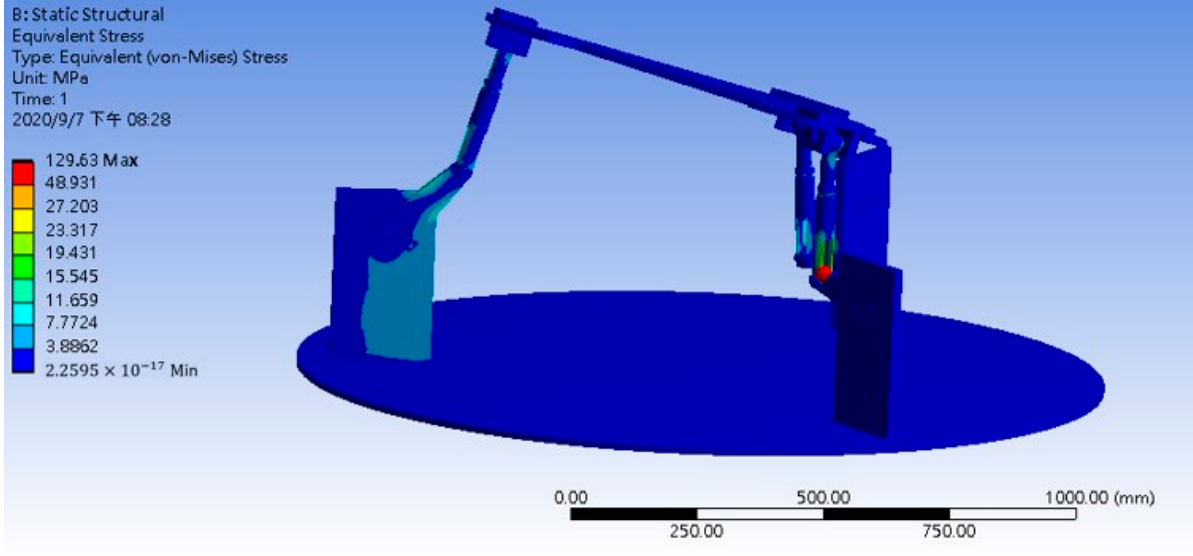
Figure 13. The maximum stress of the roll motion.